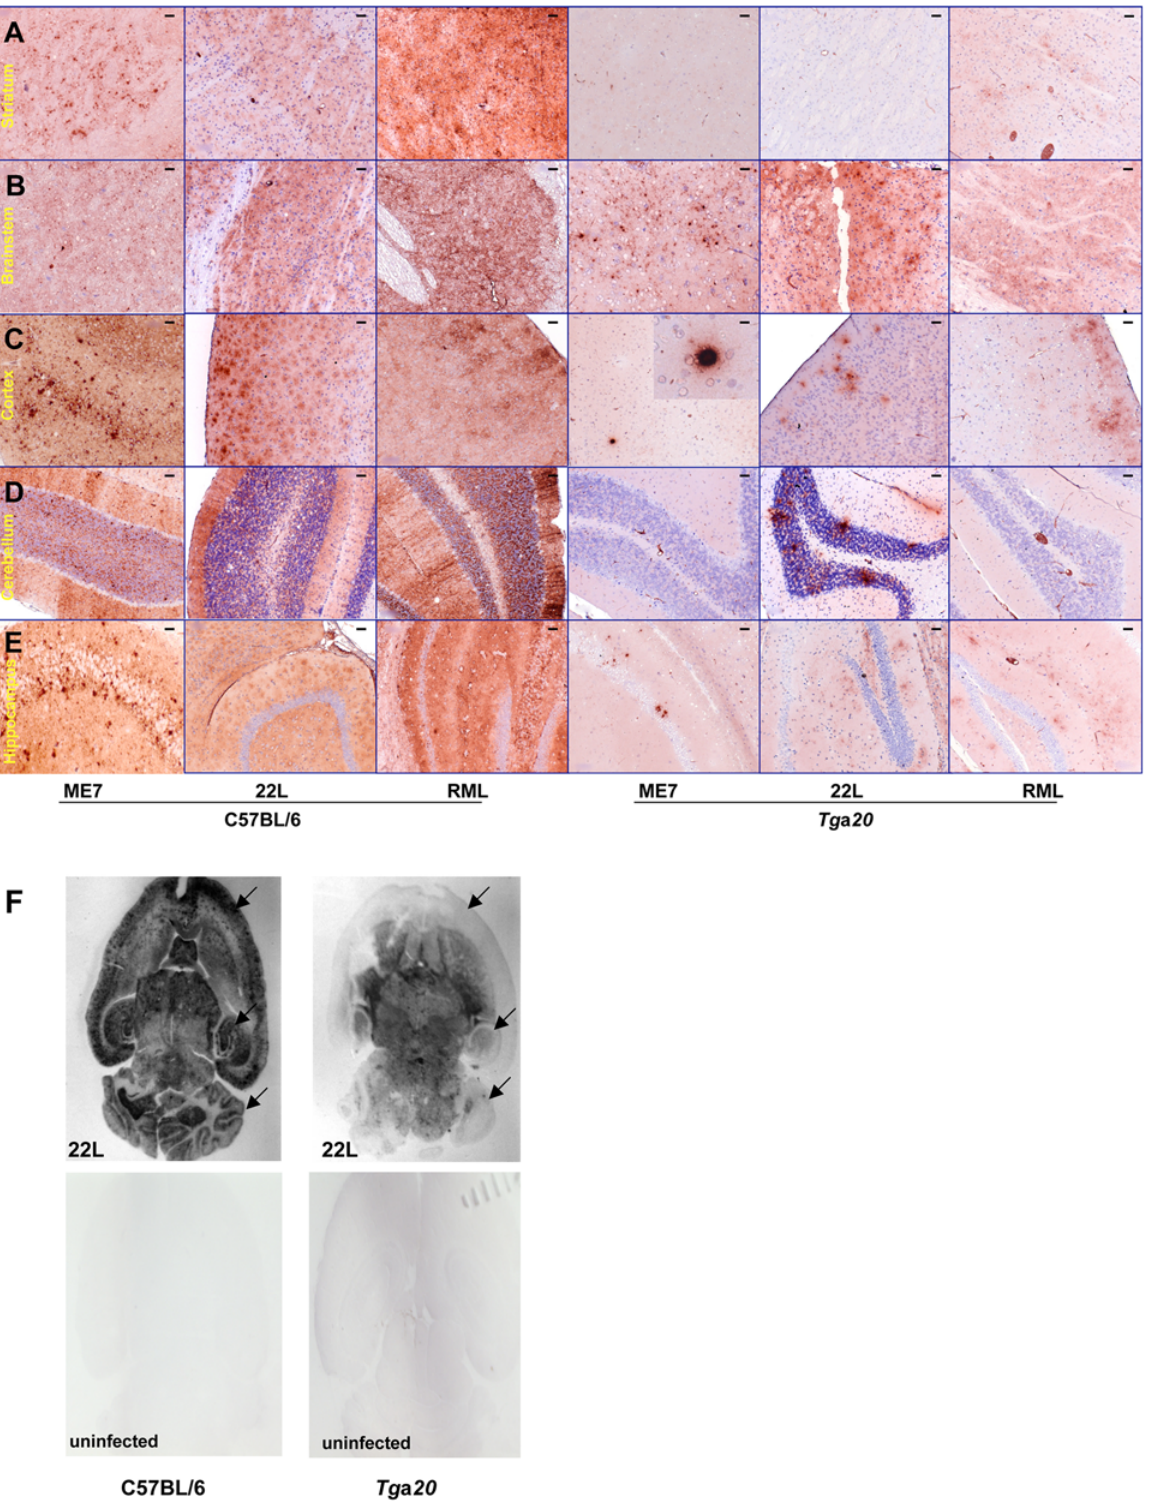
Figure 4. PrP Sc deposition pattern in C57BL/6 and Tg a 20 mice infected with three scrapie prion strains. Although PrP C levels are higher in all brain regions of Tg a 20 as compared to C57BL/6 mice, PrP Sc levels were lower in Tg a 20 mice except for the brainstem and thalamus (see also Fig. S1). PrP Sc was detected by IHC using anti-PrP mouse monoclonal antibody Bar 233 (SpiBio) and secondary anti-mouse IgG antibody, as described in the methods section. Bar 233 stains PrP Sc deposits with various morphologies in the brains of C57BL/6 and Tg a 20 mice infected with ME7, 22L and RML scrapie strains. Only faint diffuse cytoplasmic and neuropil staining was seen in uninfected mouse brains (Fig. S1). The secondary antibody alone stains only plasma in the blood vessels, as can be seen in large vessels in the last pictures on the right of A, D and E. A , striatum; B , brain stem; C , cortex; D , cerebellum; E , hippocampus. Table 4 summarizes the findings. Bars represent 50 m m. F : PET-BLOTS of horizontal brain sections from Tg a 20 and C57BL/6 mice infected with the 22L strain and the corresponding uninfected control mice. Arrows show the cortexes, hippocampi and cerebella.